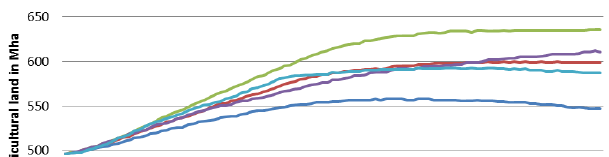
Figure B4. Distribution of population for SSP2-RCP6.0 for the years (a) 2000 and (b) 2050. Grid cells with less than one person per km 2 are excluded.